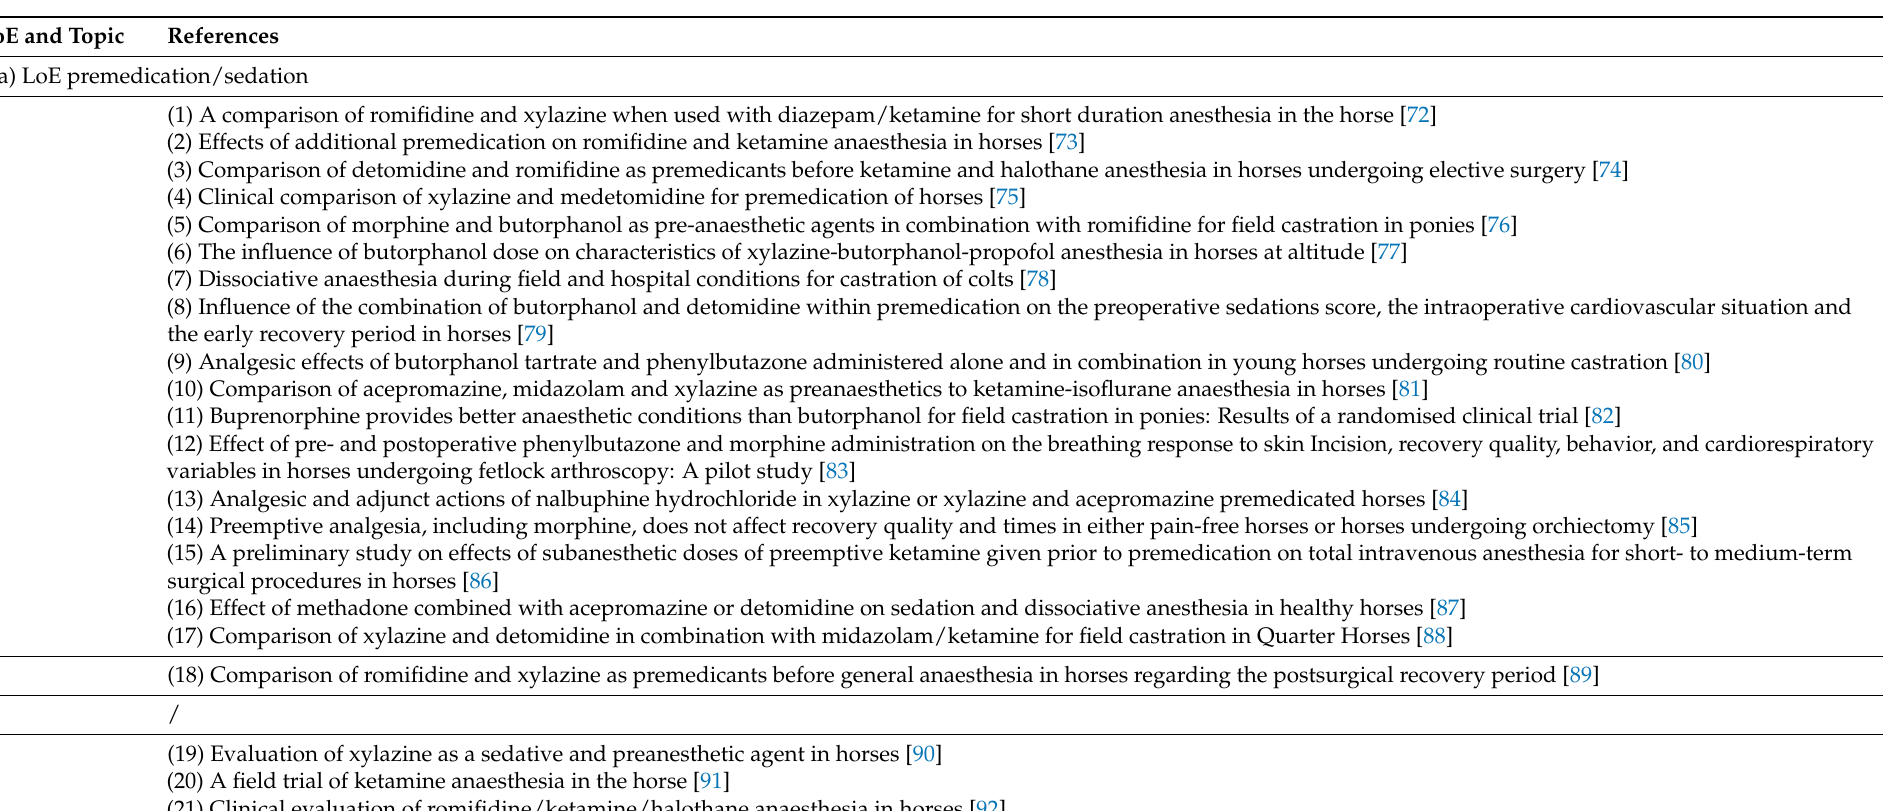
Table 4. Total of publications giving information about effects of (4a) “ premedication/sedation ”, (4b) “ induction drugs ” and (4c) “ sedation and induction drugs ” on the recovery